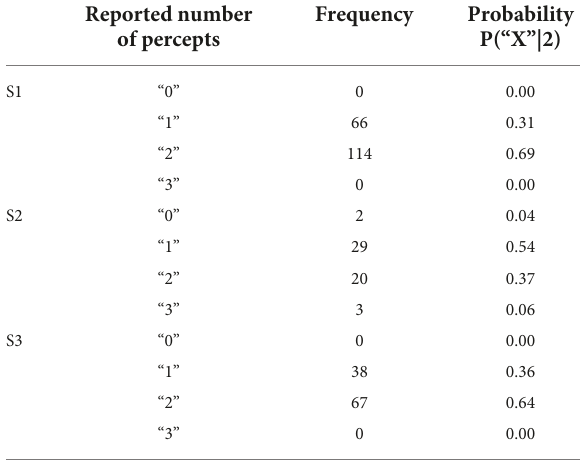
TABLE 4 Reported number of percepts and their frequency and probability in the two-point discrimination experiment. Reported number of